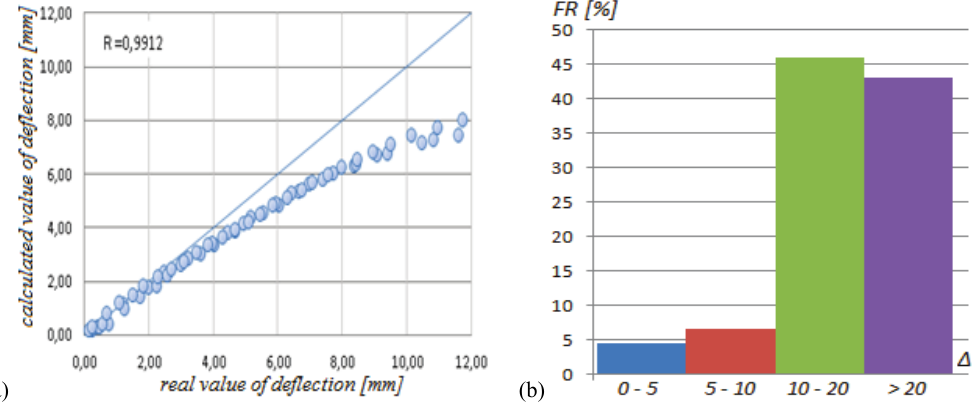
Fig. 12. Comparison of deflections a obtained from studies with values calculated according to the standard [5]: (a) correlation diagram of results, (b) histogram of the relative